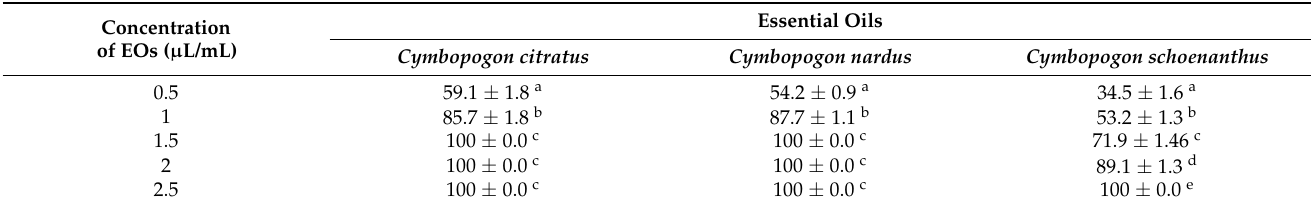
Table 4. Inhibition of mycelial growth of Aspergillus parasiticus (%), depending on the concentration of the essential